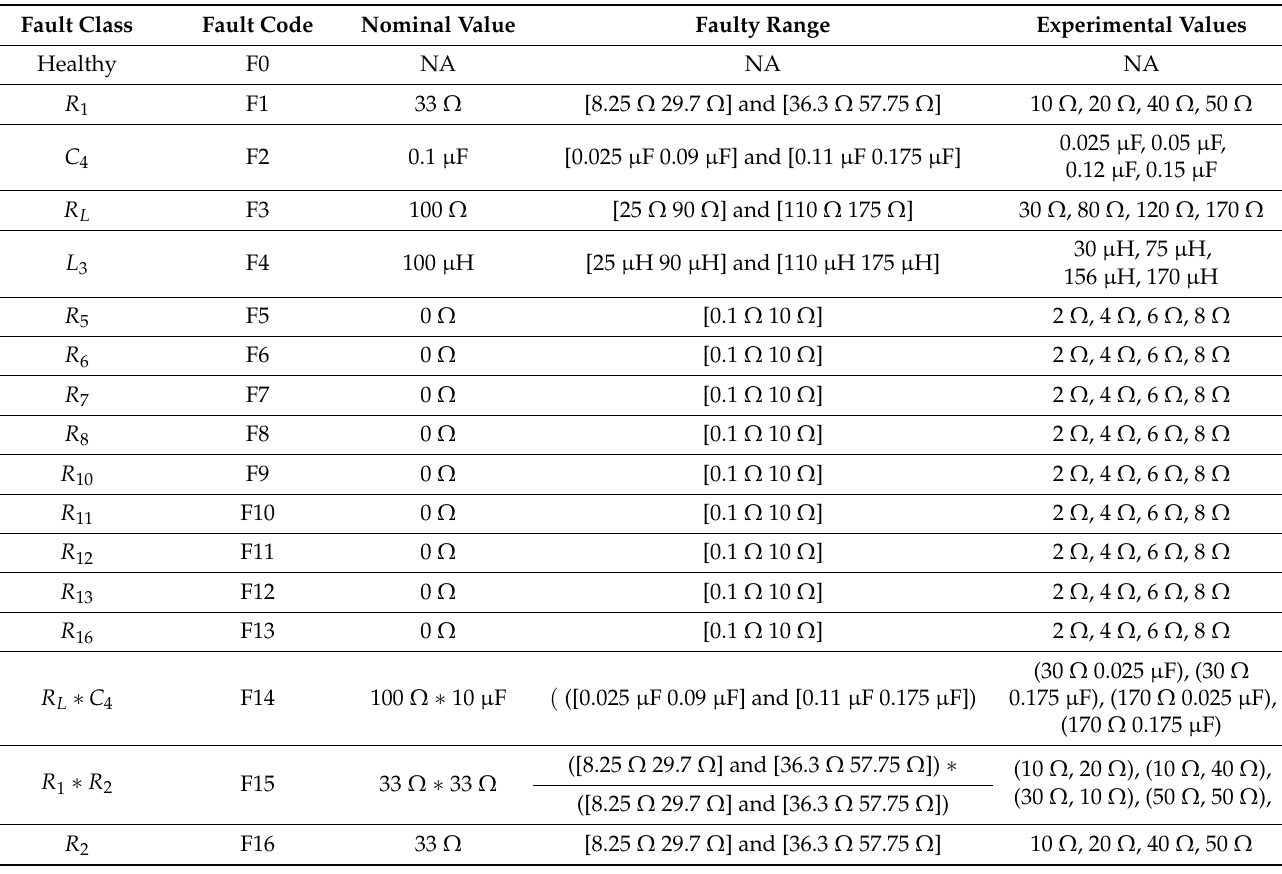
Table 5. Nominal values and parametric fault range of two-switch forward convertor circuit components.